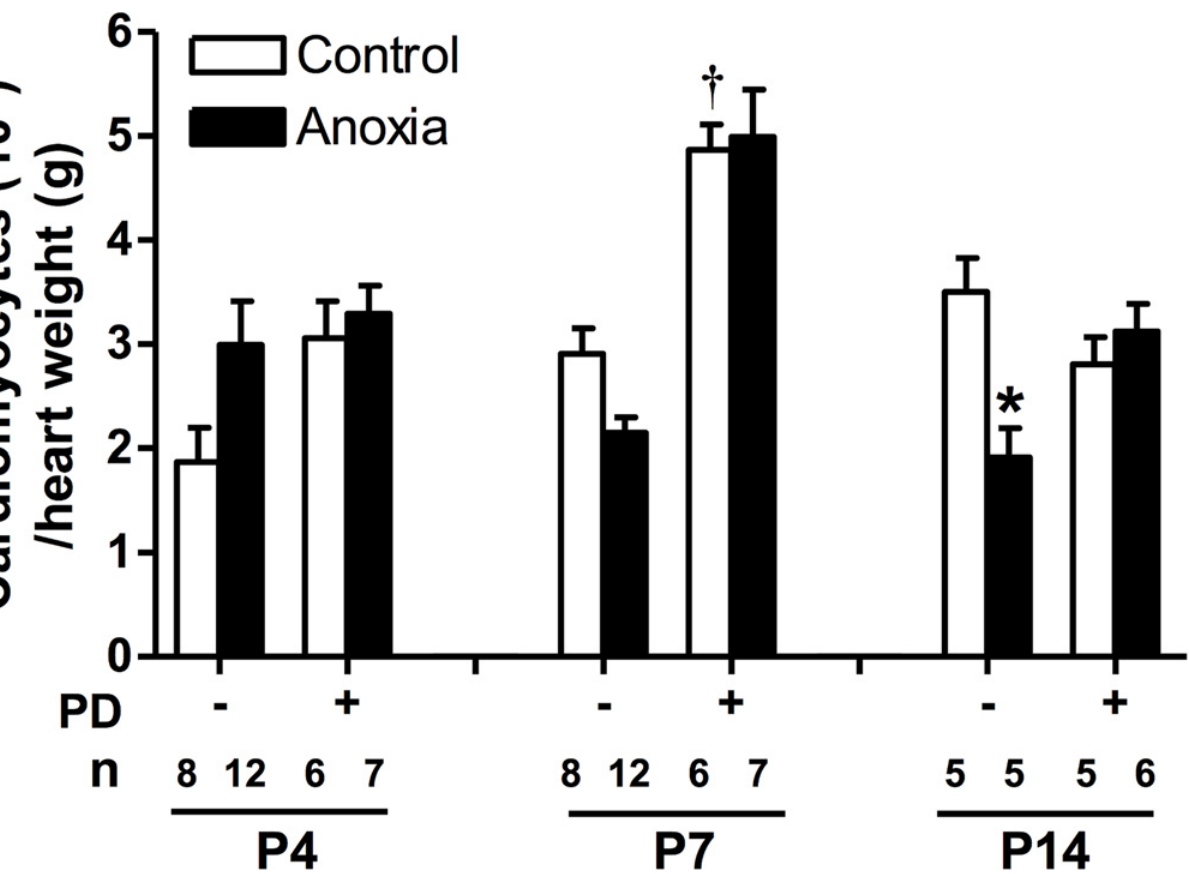
Fig 5. Effect of newborn anoxia and PD156707 on number of cardiomyocytes per heart weight. Cardiomyocytes were isolated from day 4, 7, and 14 neonatal rats that were treated with control or anoxia, in the absence or presence of PD156707. Hearts were weighed and cardiomyocytes counted by hemacytometer. Data are expressed as cardiomyocyte number/g heart weight, and are means ± SEM. * P < 0.05, anoxia vs . control. † P < 0.05, -PD156707 vs . +PD156707. PD: PD156707; n: animal